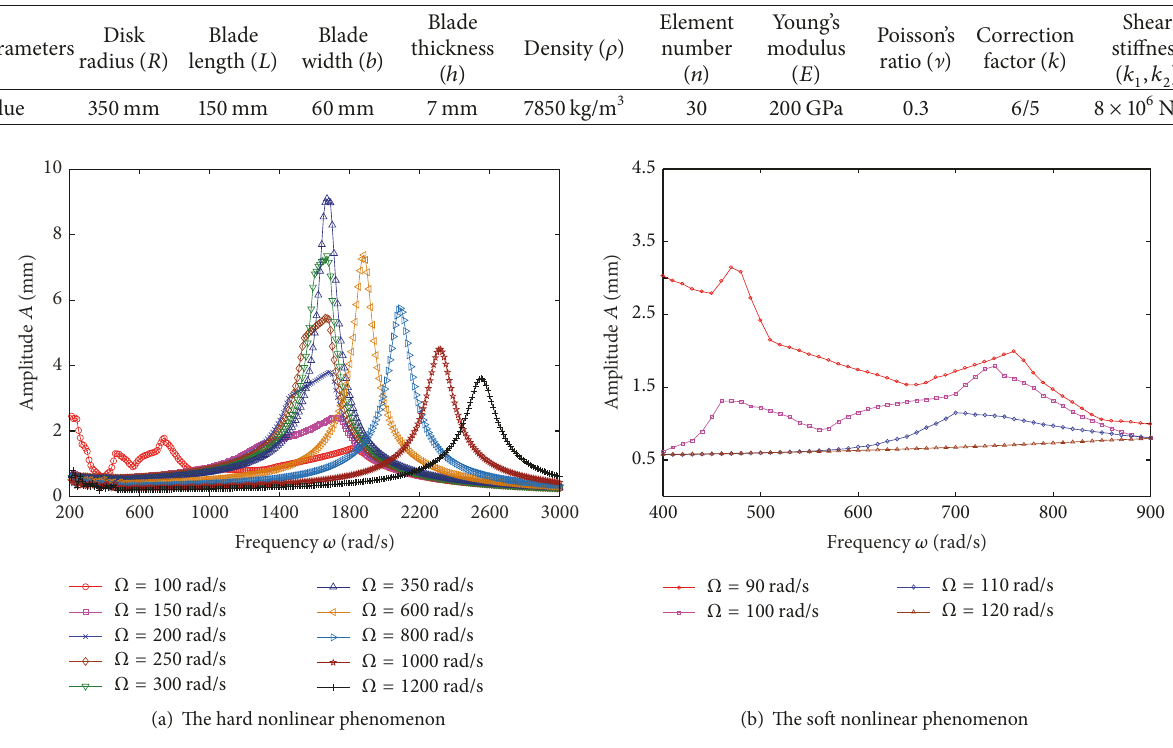
Table 1: The default parameters of the blade system.